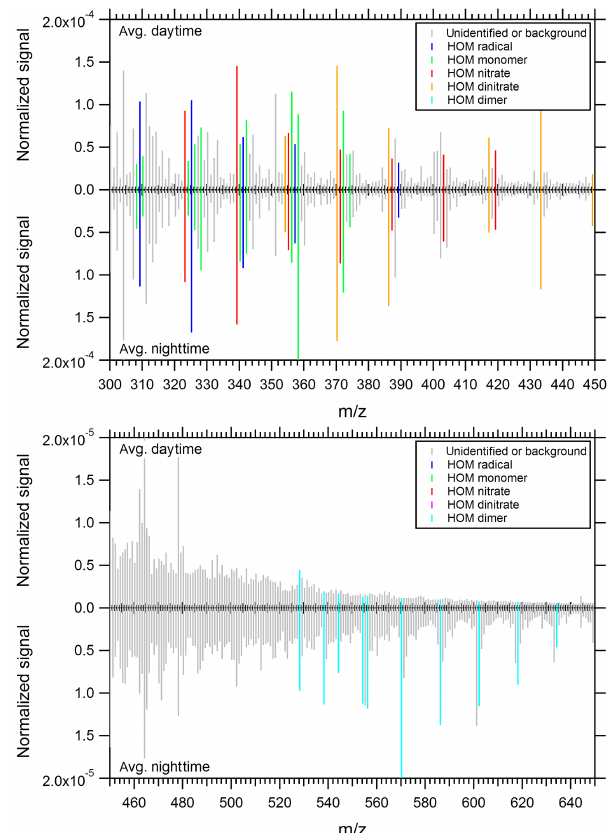
Figure 7. Comparison between average daytime and nighttime mass spectra measured with the nitrate CI-APi-TOF. The daytime spectrum was averaged for periods when no nucleation was ob-